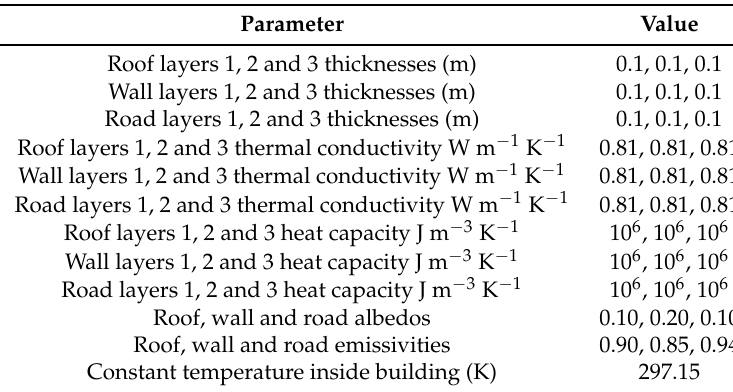
Table 4. Average values of parameters for the urban landscape used in the tTEB scheme based on a previous contribution